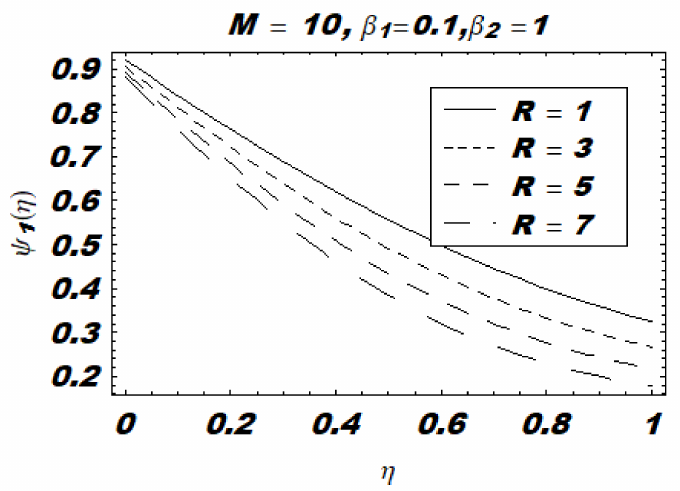
for the circular slider. 3